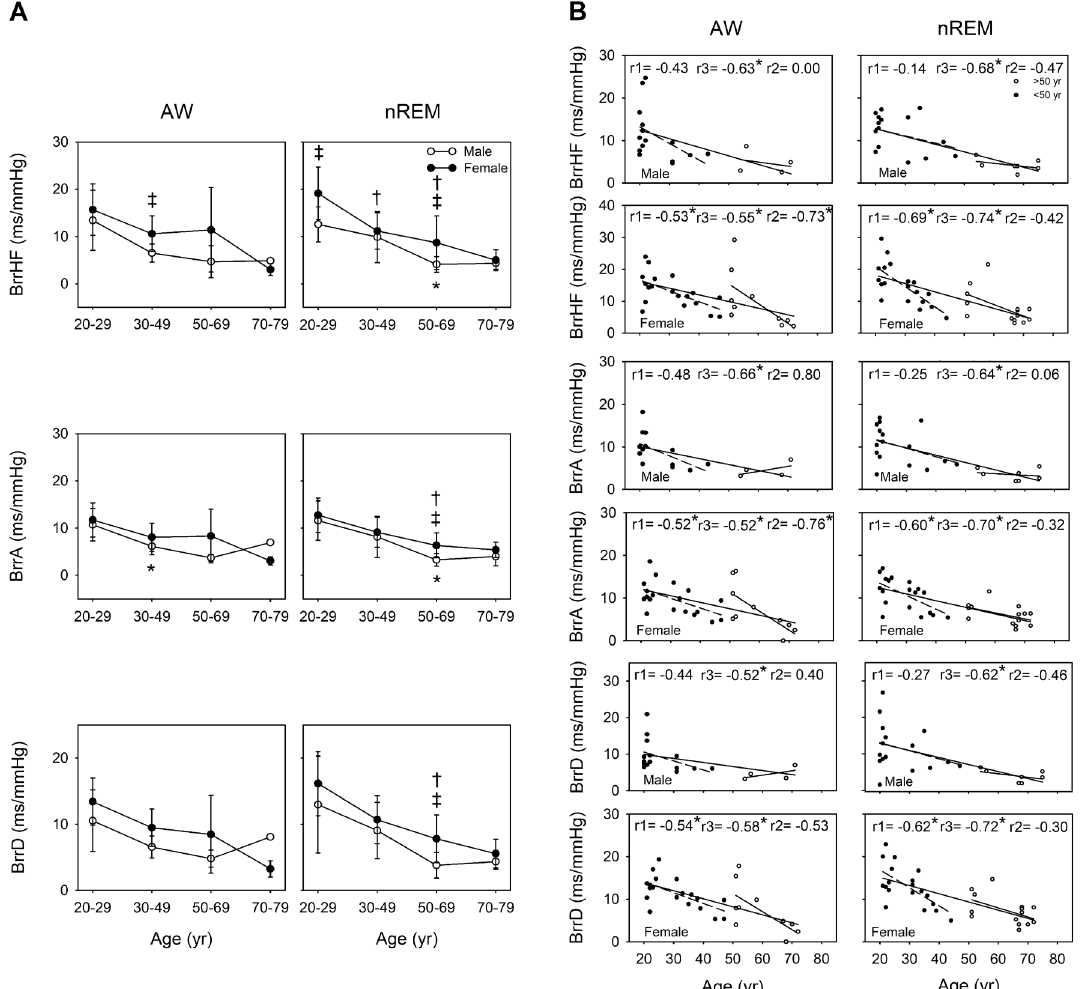
Figure 4. Comparison of baroreflex sensitivity (BRS) between wakefulness (AW) and non-rapid eye movement sleep (nREM) for the different age groups in men and women ( A ). * p < 0.05 vs. 20–29-year-old men. † p < 0.05 vs. 20–29-year-old women. ‡ p < 0.05 vs. men. The values are presented as means ± SEMs. Two-dimensional scattergrams for the BRS–age relationship during AW and nREM in men and women ( B ). * p < 0.05. r1: correlation coefficient in the 20–49-year age group. r2: correlation coefficient of 50–79-year age group. r3: correlation coefficient of 20–79-year age group. Abbreviations: ln, natural logarithm; BrrHF, magnitude of MAP–R-R interval transfer function; BrrA/BrrD, slope of MAP–R-R interval linear